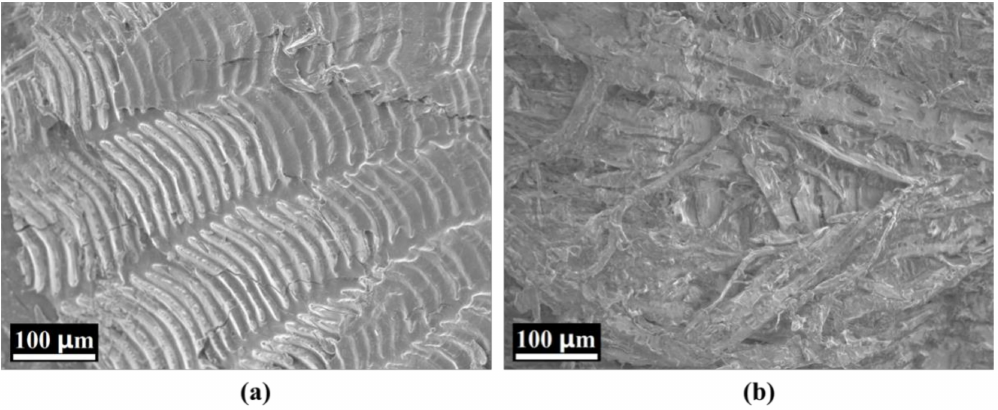
Figure 3. Scanning electron microscopy (SEM) images of ( a ) carp scale and ( b ) carp